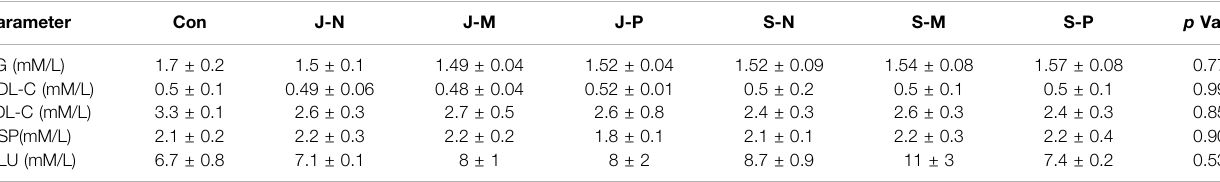
TABLE 6 | Lipid and glucose metabolism after different PAL treatments.